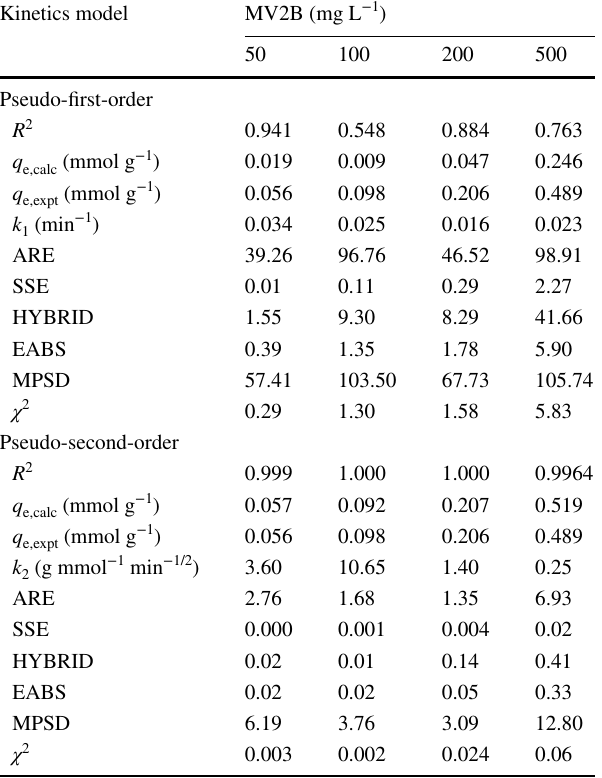
Table 7 Parameters and error functions of pseudo-first-order kinet- ics model and pseudo-second-order kinetics models for adsorption of MV2B on IA Kinetics